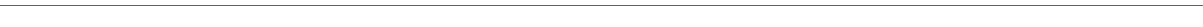
FigUre 7 | Thrombin-induced proliferation and survival are angiopoietin-2-dependent. In all, responses of wild-type (WT) CD34 + cells are shown as white bars, whereas purified CD31 + myofibrocytes from CD31-TFPI-Tg mice are shown as black bars. 0*Indicates incubation with active site inhibited thrombin. Abbreviations: Csi, control scrambled siRNA; Ang-2si, siRNA specific for angiopoietin-2. (a) Expression of angiopoietin-2 at baseline and after incubation with thrombin for 5 days, expressed as the percentage of CD34 + cells staining positive in immunocytofluoresence analysis. (B) Secretion of angiopoietin-2 into supernatant after 5-day incubation with thrombin at the indicated concentrations, analyzed by ELISA. (c) Expression of smooth muscle actin (SMA) and joint expression of CD31 with SMA at baseline and after incubation with thombin for 5 days, either alone or with anti-TIE-2 antibody or siRNA against angiopoietin-2 or control. Data expressed as the percentage of CD34 + cells staining positive in immunocytofluoresence analysis. (D) As (c) but cells incubated with angiopoietin-2 ± anti-TIE-2 antibody. (e) Proliferation, assessed by 3 H-thymidine incorporation and expressed as counts per minute (CPM) after incubation with thrombin at the indicated concentrations. (F) Proliferation, assessed by 3 H-thymidine incorporation and expressed as CPM after incubation with angiopoietin-2 at the indicated concentrations. (g) Degree of apoptosis after incubation with thrombin or angiopoietin-2 at the indicated concentrations. Anti-TIE-2 antibody used at 50 ng/ml. All experiments repeated at least